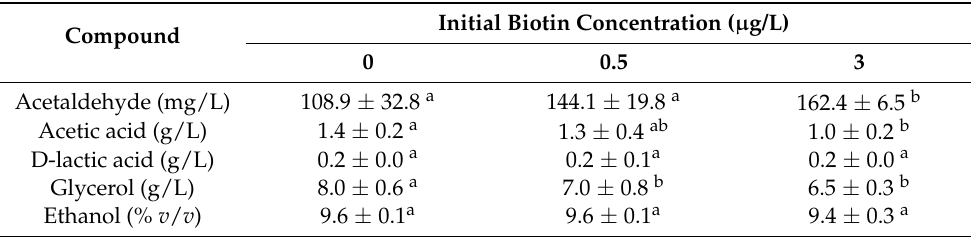
Table 4. Central carbon metabolites in the final wines produced in varying initial biotin concentra- tions.